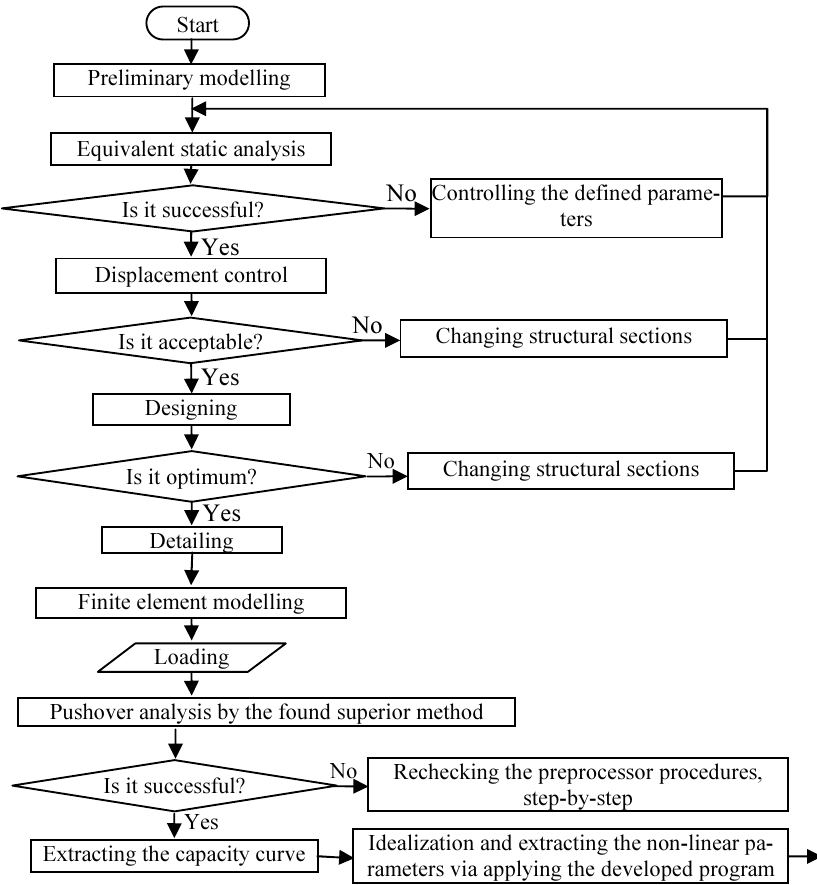
Fig. 6. Flow chart of the procedure passed for each of the 30